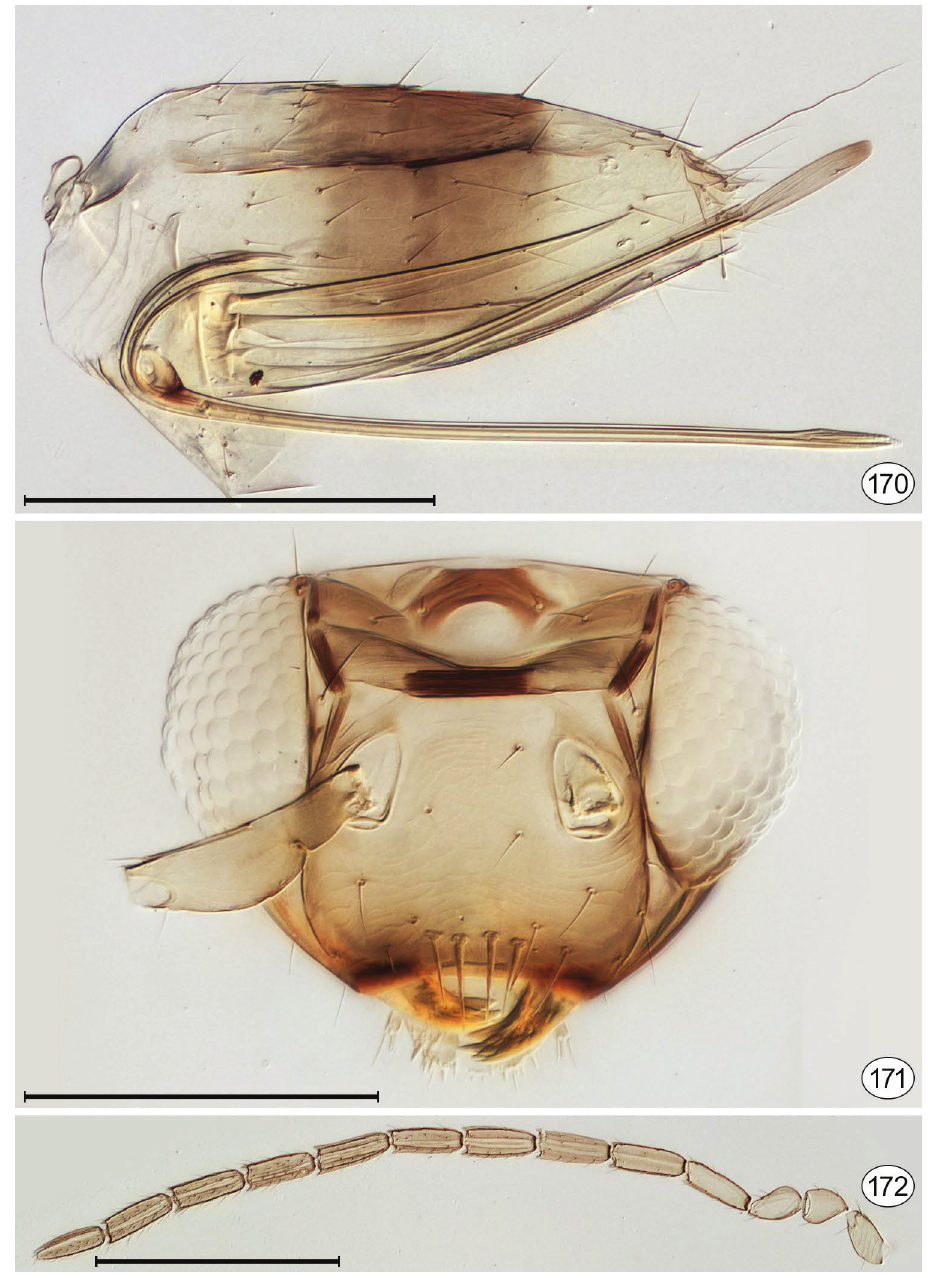
Figures 170–172. Proarescon similis . 170 holotype metasoma, lateral 171 male paratype head, anterior 172 male paratype antenna. Scale bar for 170, 172 =200 μm; 171 =100